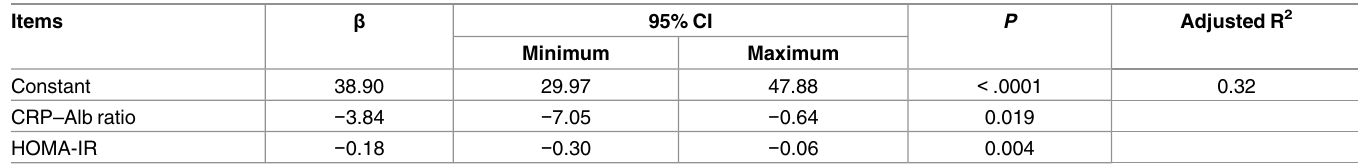
Table 4. Stepwise multiple regression analysis using SMM/wt as a dependent variable 1